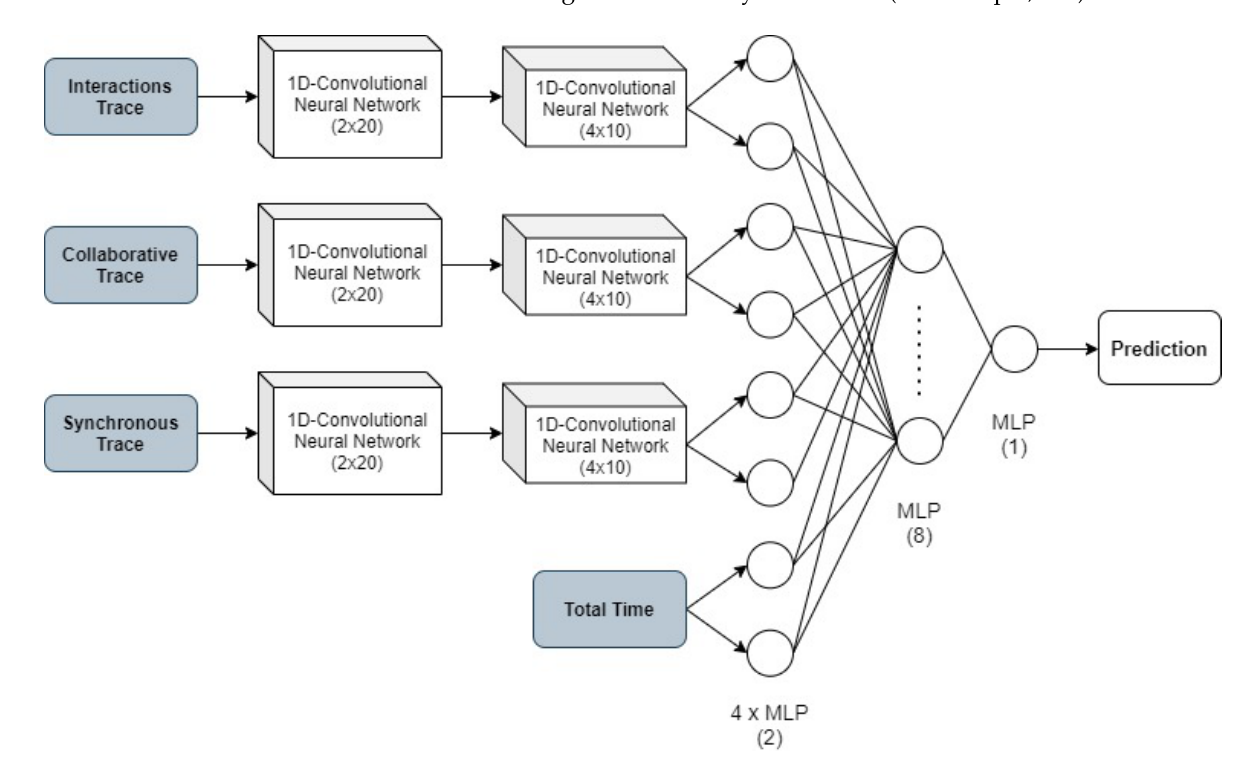
Figure 4. Architecture of the proposed